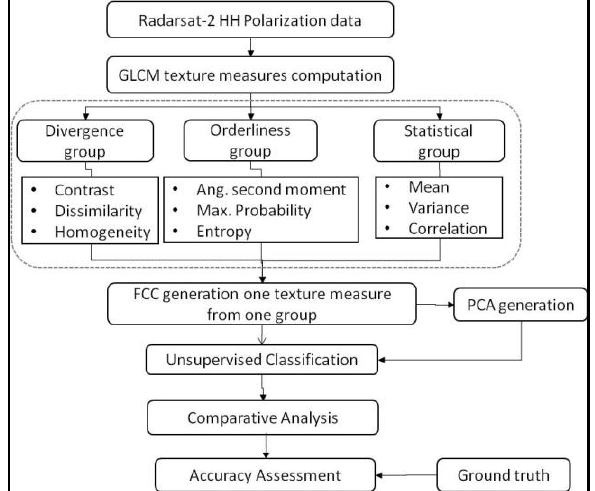
Figure 2. Methodology flow chart – Land